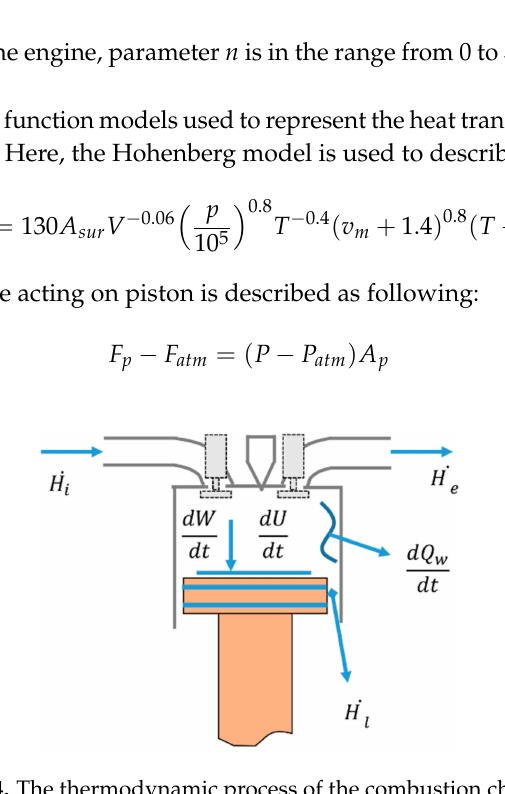
Figure 4. The thermodynamic process of the combustion chamber.